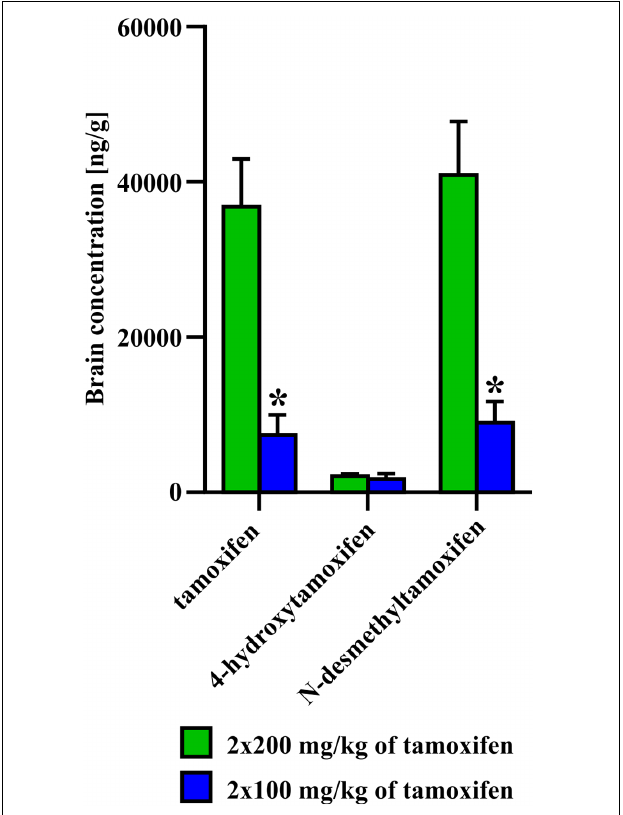
FIGURE 5 | Difference in concentration of 4-hydroxytamoxifen at day 0, after administration of 2 × 200 or 2 × 100 mg/kg of tamoxifen. No difference in concentration of 4-hydroxytamoxifen, unlike those of tamoxifen and N -desmethyltamoxifen, suggests that the pathway toward the most potent metabolite is saturated already, when 2 × 100 mg/kg of tamoxifen i.p. was administrated. Values of p < 0.05 were considered significant ( ∗ ).